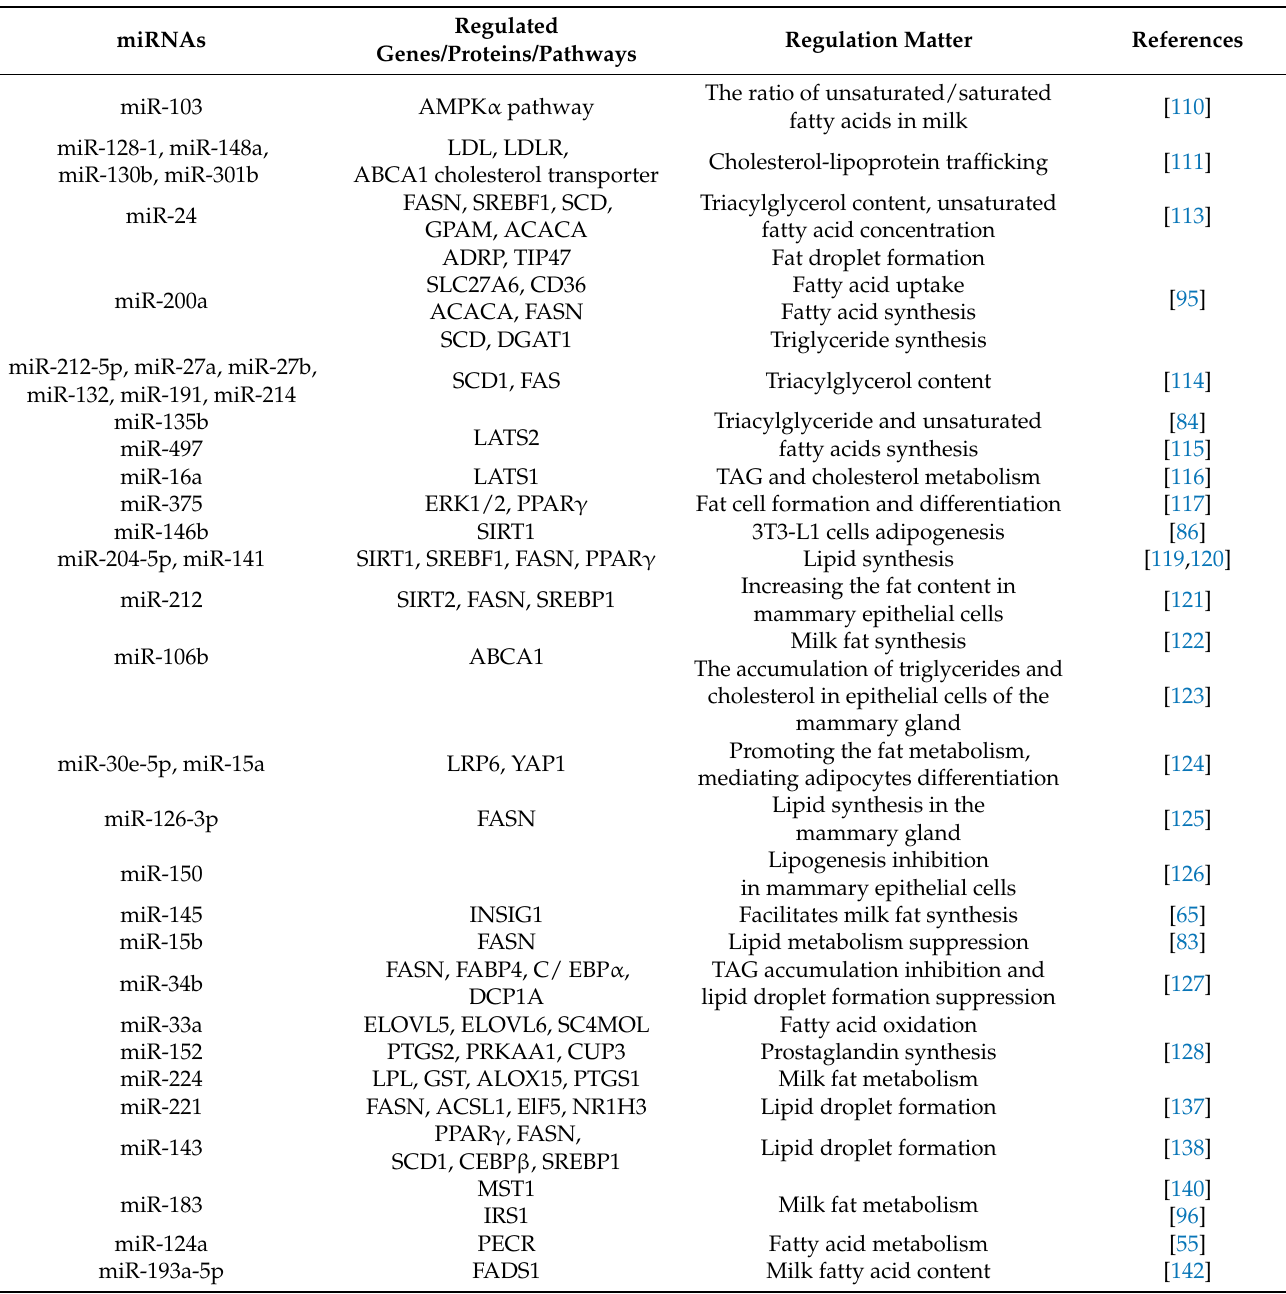
Table 6. A brief summary of the involvement of several miRNAs in lipid